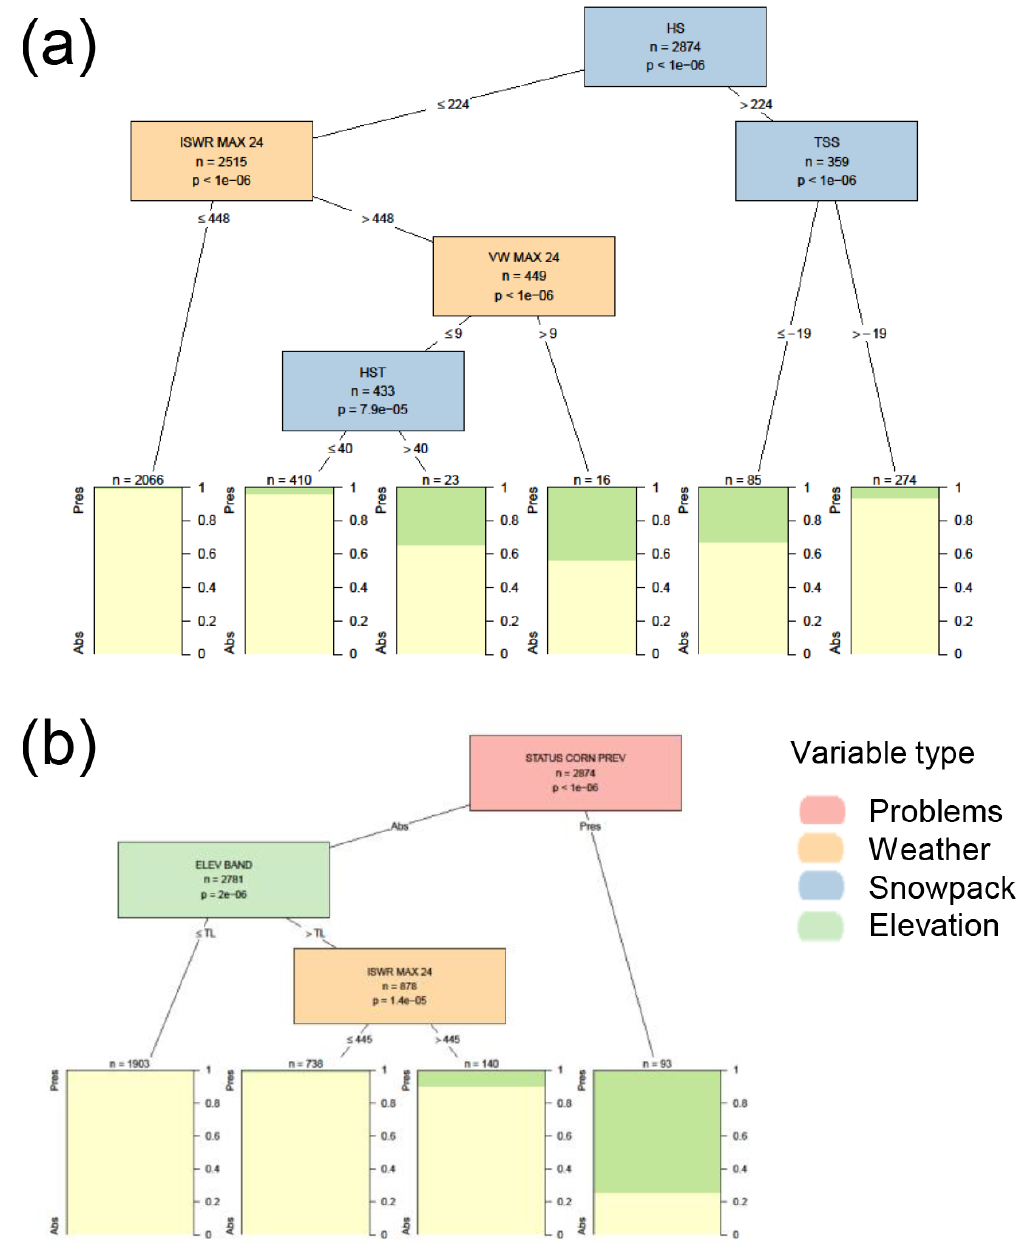
Figure C4. Conditional inference tree for the presence or absence (Pres/Abs) of cornice avalanche problems (a) based on weather and snowpack variables and (b) including additional contextual variables about the hazard assessment. Variables appearing in the trees include the total snow height incm (HS), the maximum incoming shortwave radiation in the past 24h in Wm − 2 (ISWR MAX 24), the maximum hourly wind speed in the past 24h in ms − 1 (VW MAX 24), the height of new snow since the last snow-free day (HST), the snow surface temperature in ◦ C (TSS), the presence or absence of a cornice problem the previous day (STATUS CORN PREV), and the elevation band (ELEV BAND) relative to the treeline band (TL). Terminal nodes show the proportion of cases with cornice problems present (green) and absent